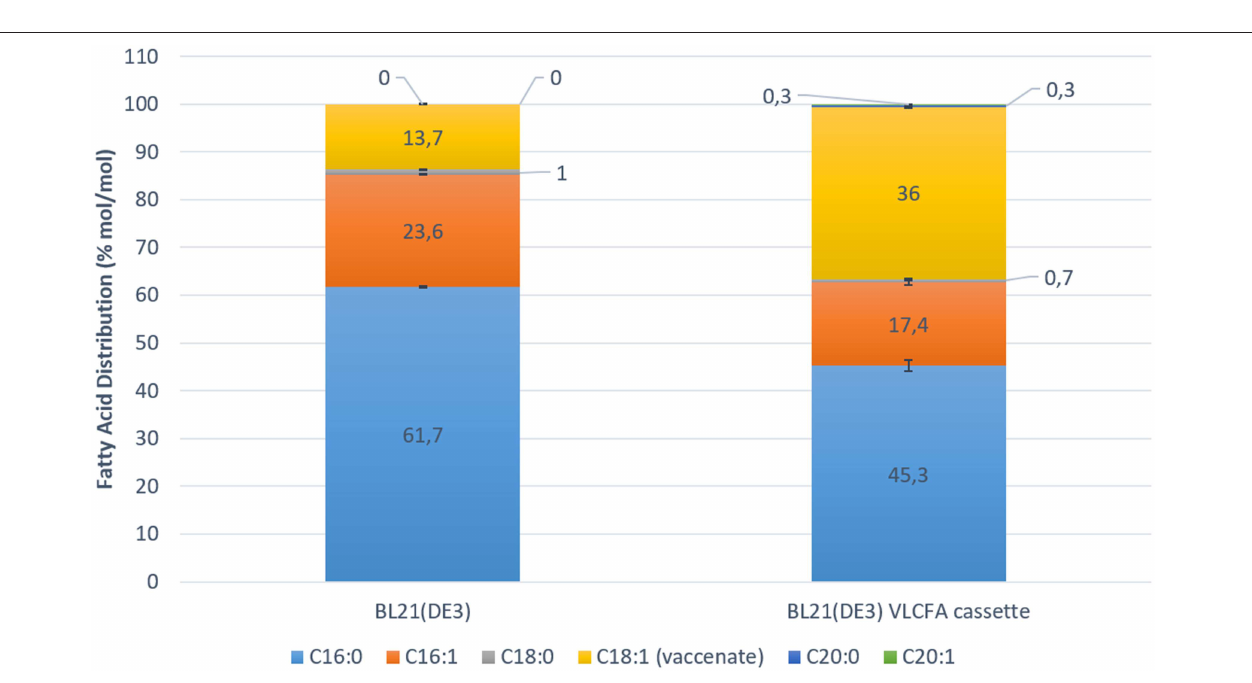
FIGURE 5 | Fatty acid distribution mol/mol of control Escherichia coli BL21 (DE3) expressing pACYC-11-saGFP and pET28a-1-10saGFP vs. BL21 (DE3) expressing pACYC-VLCFA-11GFP and pET28a-1-10GFP in 100ml shake flask studies. The overall increase in C18:1 fatty acids is highly noticeable. The BL21 (DE3) VLCFA cassette profile clearly shows the production of longer than C18 fatty acids (C20:0 and C20:1) which are absent in the